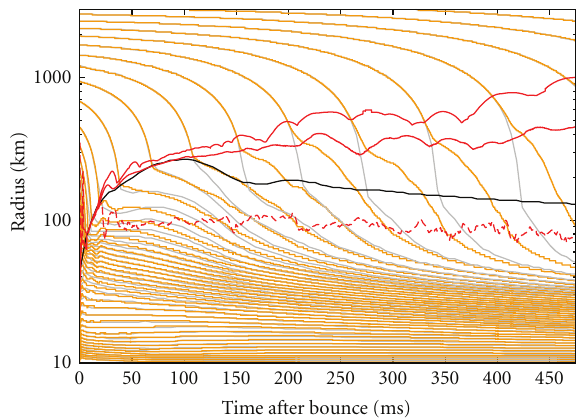
Figure 1: Time evolution of 1D (thin gray lines) or 2D (thin orange lines) hydrodynamic simulation [138] of a 13 M (cid:3) progenitor [117]. Thick lines in red (for 2D) and black (for 1D) show the position of shock waves, noting for 2D that the maximum (top) and average (bottom) shock position are shown. The red-dashed line represents the position of the gain radius, which is similar to the 1D case (not